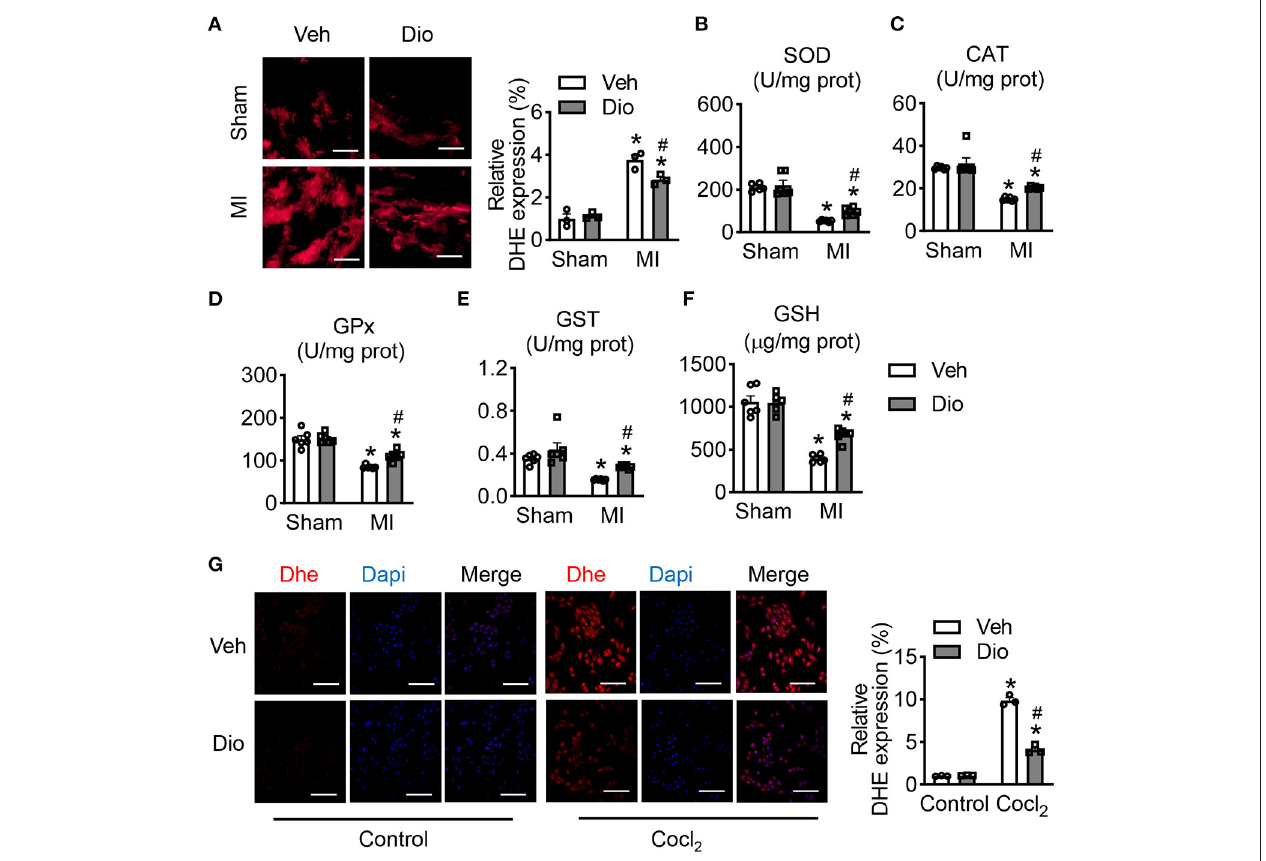
FIGURE 5 | Dioscin modulates mitochondrial antioxidant status. (A) Representative images of DHE in heart section and its qualification, bar = 50 µ m ( n = 3). The antioxidant enzymes of (B) superoxide dismutase (SOD; U/mg prot), (C) catalase (CAT; U/mg prot), (D) peroxidase (GPx; U/mg prot), (E) glutathione-S-transferase (GST; U/mg prot), and (F) glutathione (GSH; U/mg prot) ( n = 6). (G) Representative images of DHE in H9C2 cells and its quantification, bar = 50 µ m ( n = 3). Data are mean ± SEM. * P < 0.05 vs. sham group, # P < 0.05 vs. MI